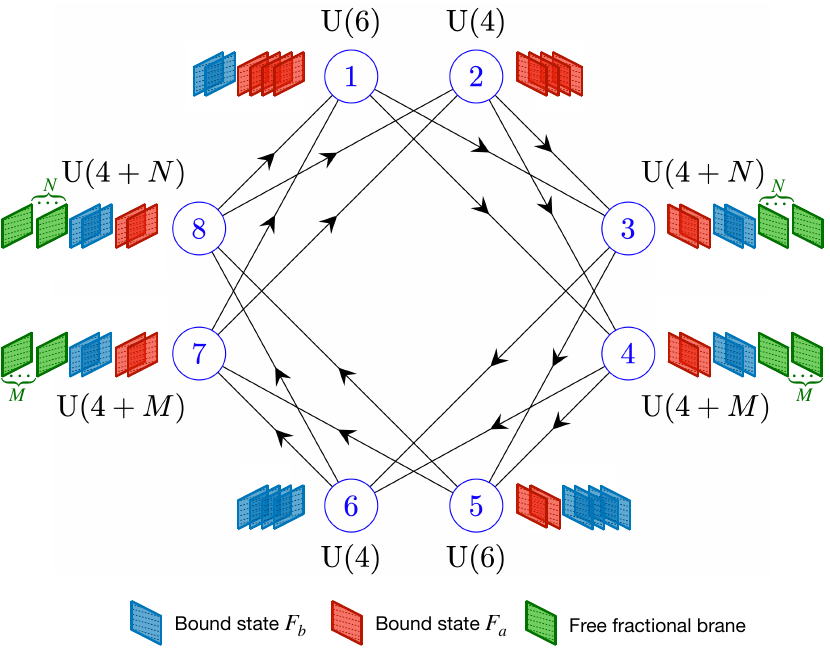
Figure 6 . Model I quiver diagram dP 5 with the bound state 2 F a indicated in red and 2 F b in blue. The green fractional branes do not participate in any bound